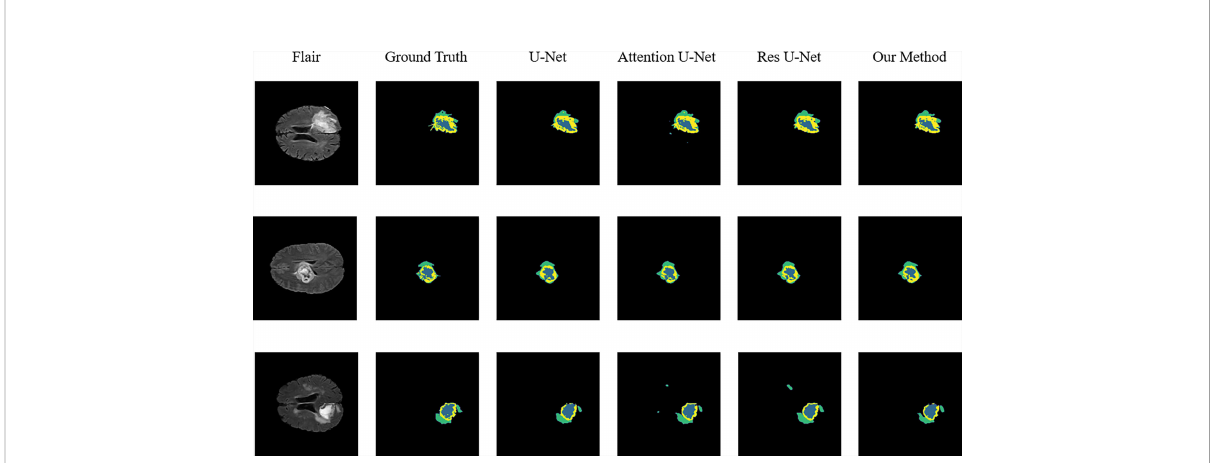
FIGURE 3 Sample segmentation results. Column 1, input images; column 2, brain tumor ground truth (GT) images; column 3, segmented results of U-Net; column 4, segmented results of Attention U-Net; column 5, segmented results of Res U-Net; column 6, segmented results of our method (ET, blue; TC, yellow + blue; and WT, green + yellow + blue).